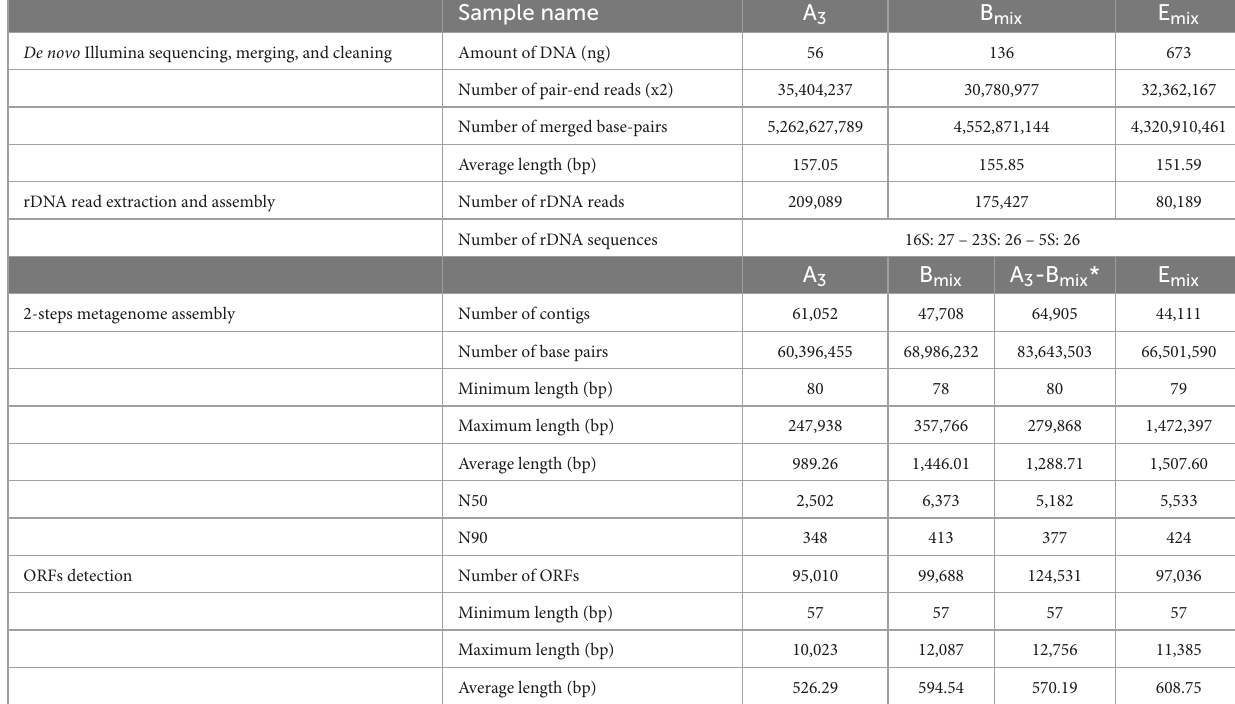
TABLE 2 Genetic materials of East Skaftárkatlar lake and associated analyses used in this study (*A 3 -B mix